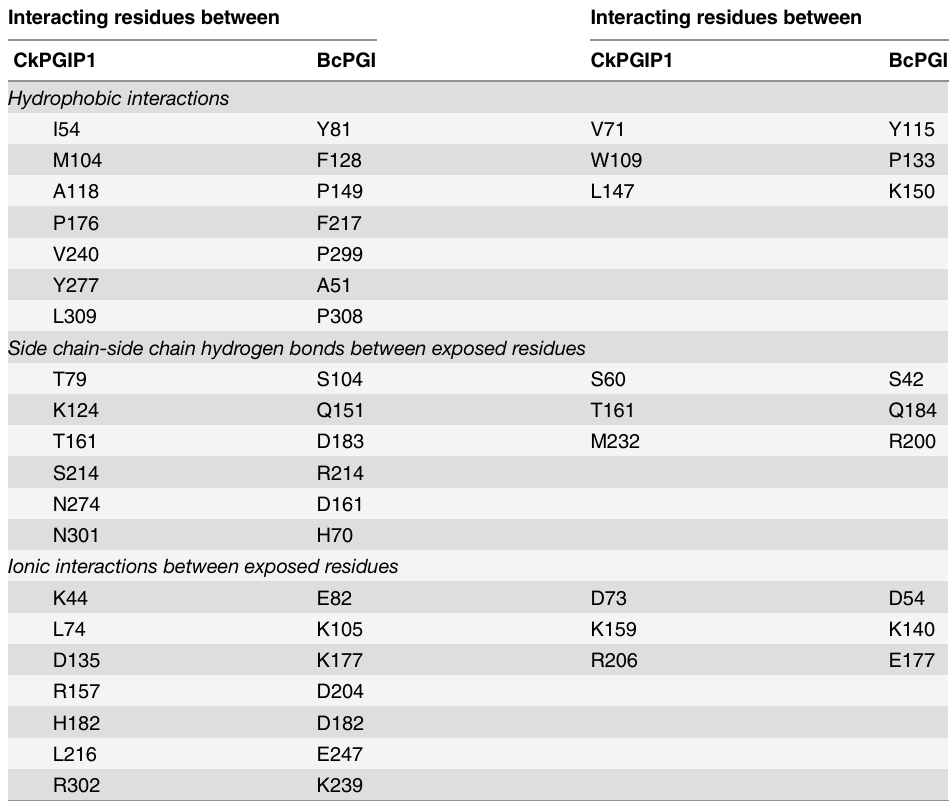
Table 1. Interacting residues between CkPGIP1 and polygalacturonase from Botrytis cinerea and Rhi- zoctonia solani , as detected by Protein Interaction Calculator. Interacting residues